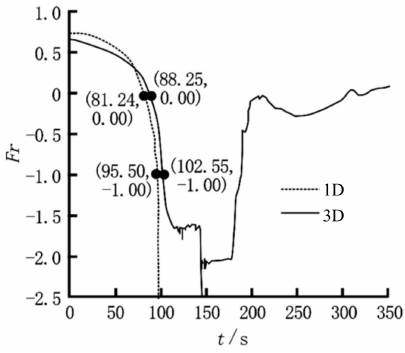
Figure 14. Change of the Froude number Fr at the combination point of the tailrace tunnel and diversion tunnel